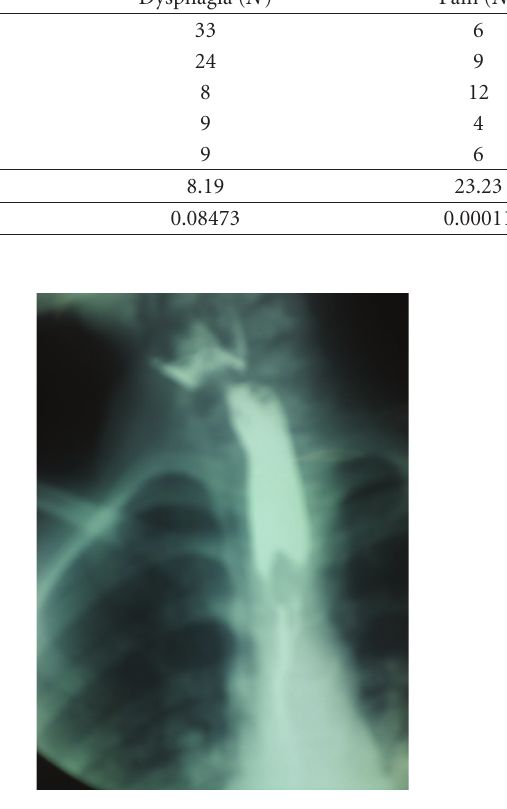
Figure 4: A clove of garlic swallowed as a pinworms